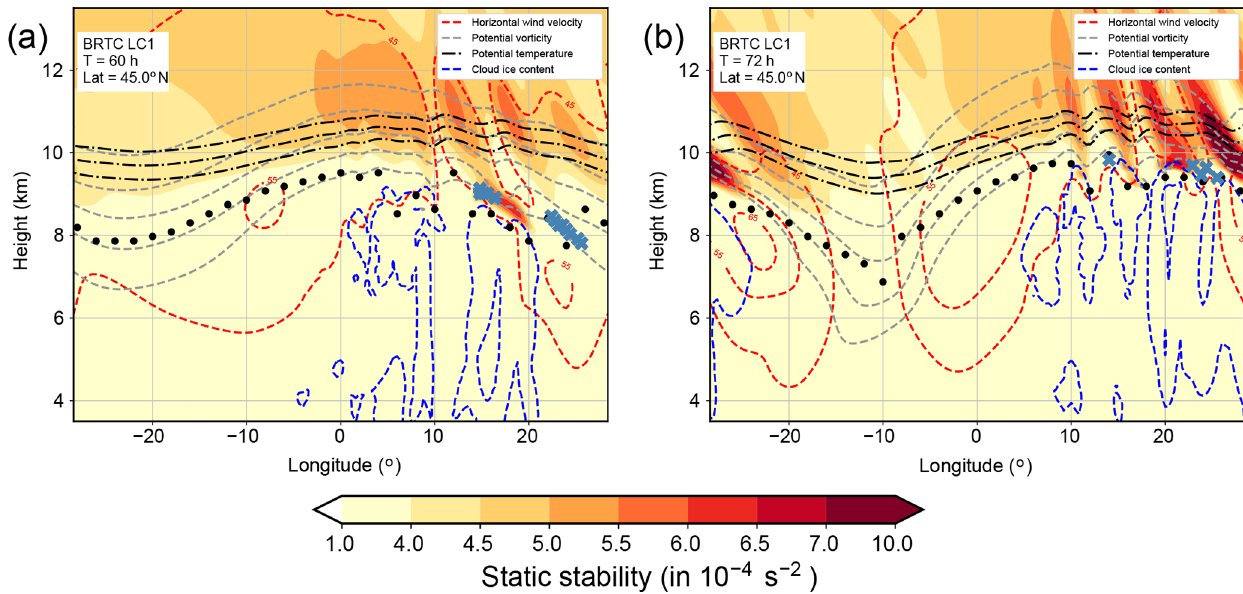
Figure 11. Zonal cross sections along the center of the model domain at 45 ◦ N show static stability (contour filled), potential temperature (330, 335, 340K, black lines), cloud ice water content (10 × 10 − 6 kgkg − 1 , blue lines), potential vorticity (2–6pvu, gray lines), and the altitude of the thermal tropopause (black dots). Red lines show isolines of the horizontal wind speed (45–65ms − 1 ) and blue crosses show points of trajectories at the respective longitude which cross the tropopause from the troposphere to the stratosphere over the course of the last 6h for (a) 60h and (b) 72h after model start.